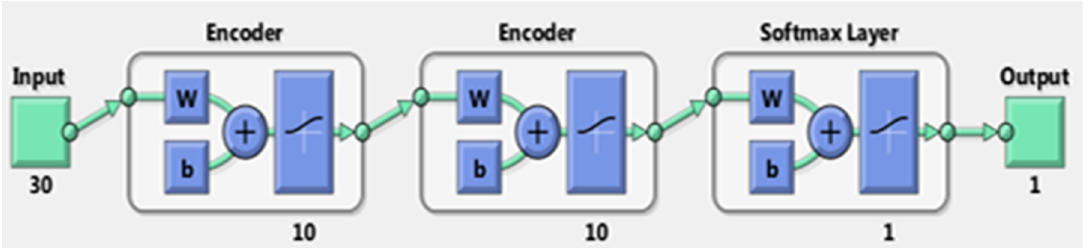
Fig. 2: Typical architecture of Deep SSAE- where input size 30 represents the input features from WDBC dataset, encoder size 10 represents the hidden unit size, Single output (either benign or